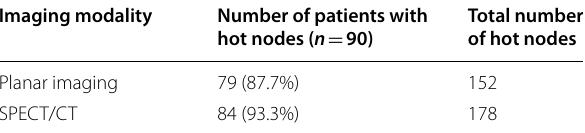
Table 5 Imaging findings of hot nodes on PS and